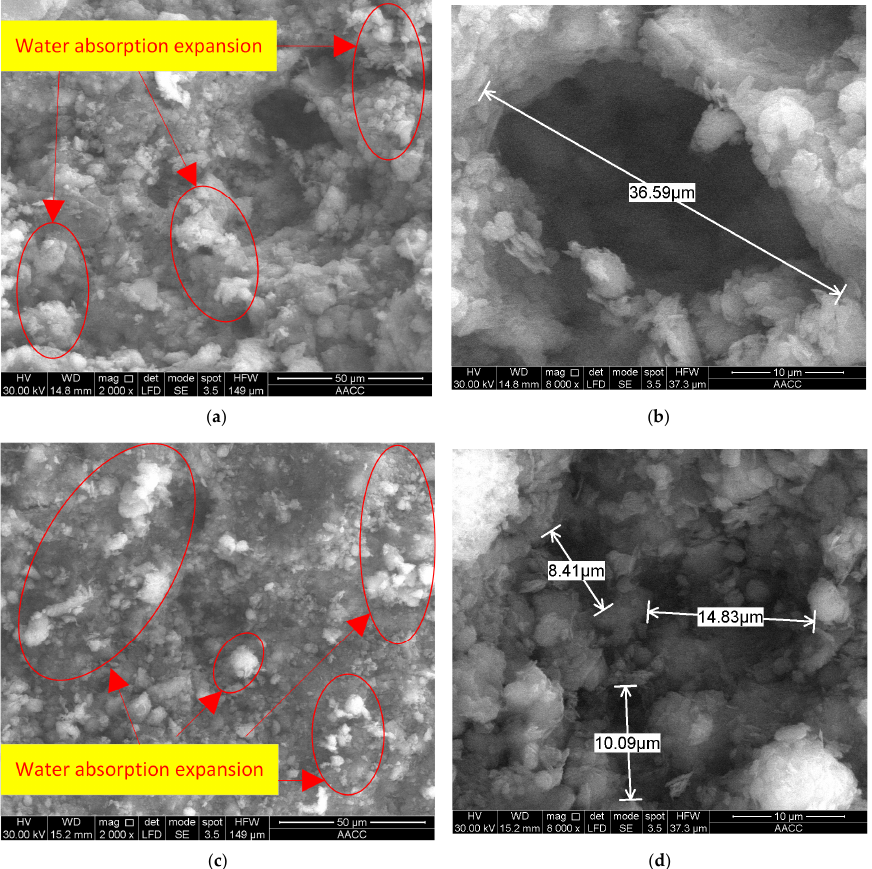
Figure 9. SEM images of mudstone and sandstone in saturated water state. ( a ) Sandy mudstone (2000× magnification); ( b ) Sandy mudstone (8000× magnification); ( c ) Mudstone (2000× magnification); ( d ) Mudstone (8000× magnification).